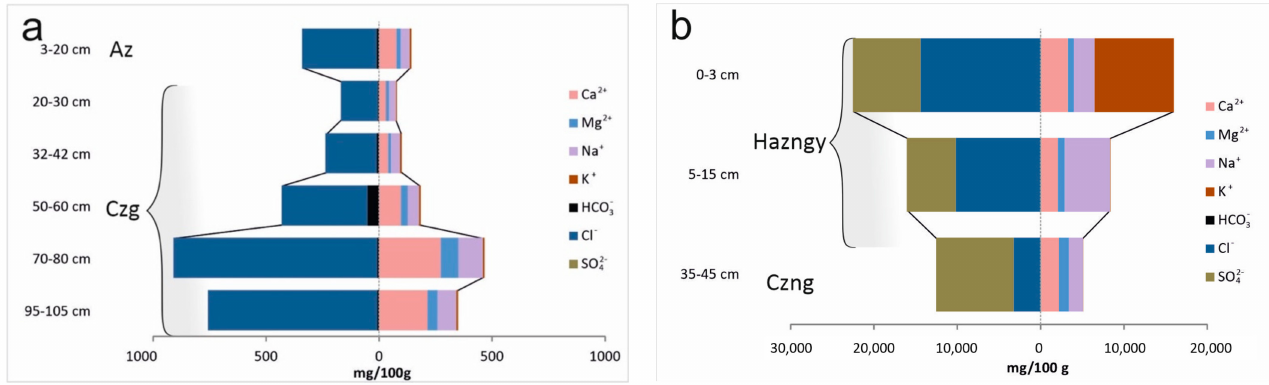
Figure 9. The content of water-soluble ions in: ( a ) Gleyic Fluvisols (Salic, Loamic, Technic); ( b ) Chloridic Gleyic Fluvic Solonchak (Hypersalic, Loamic,